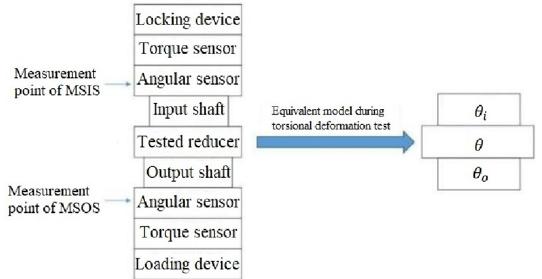
Figure 2. Diagram of the equivalent model during the torsional deformation test of the RV reducer.